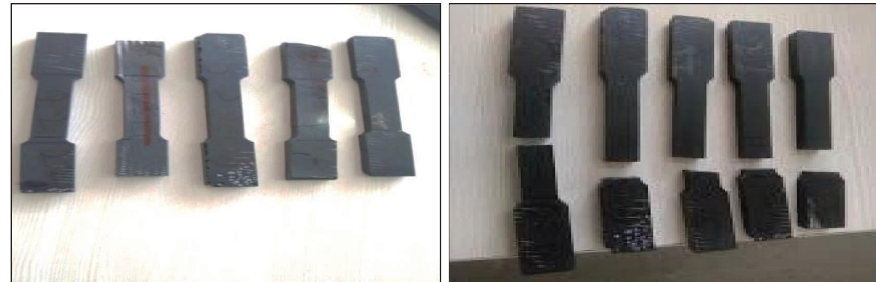
Figure 2: Flexural test specimens before and after test.